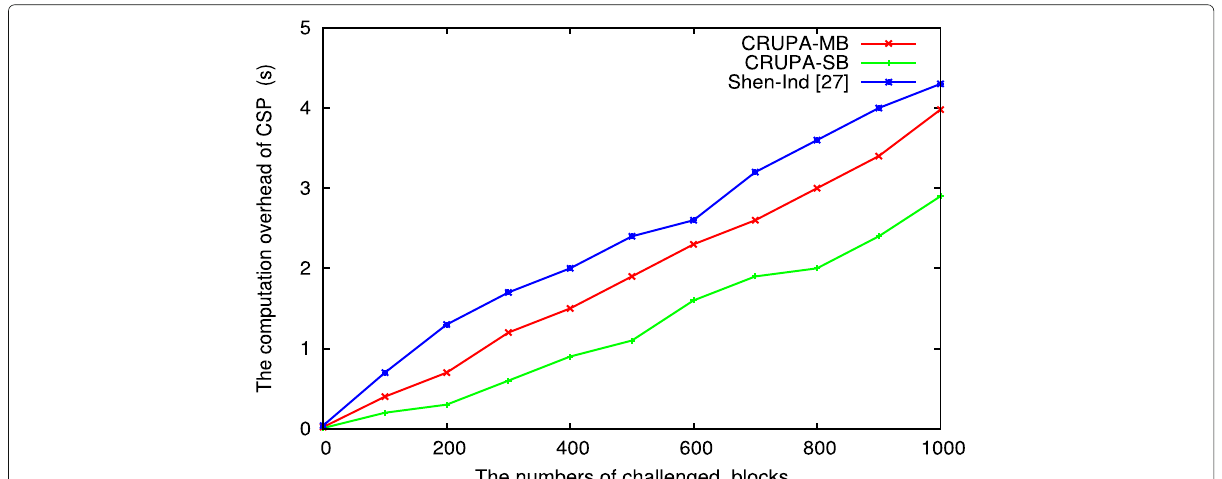
Fig. 9 Computation overhead of CSP during proof